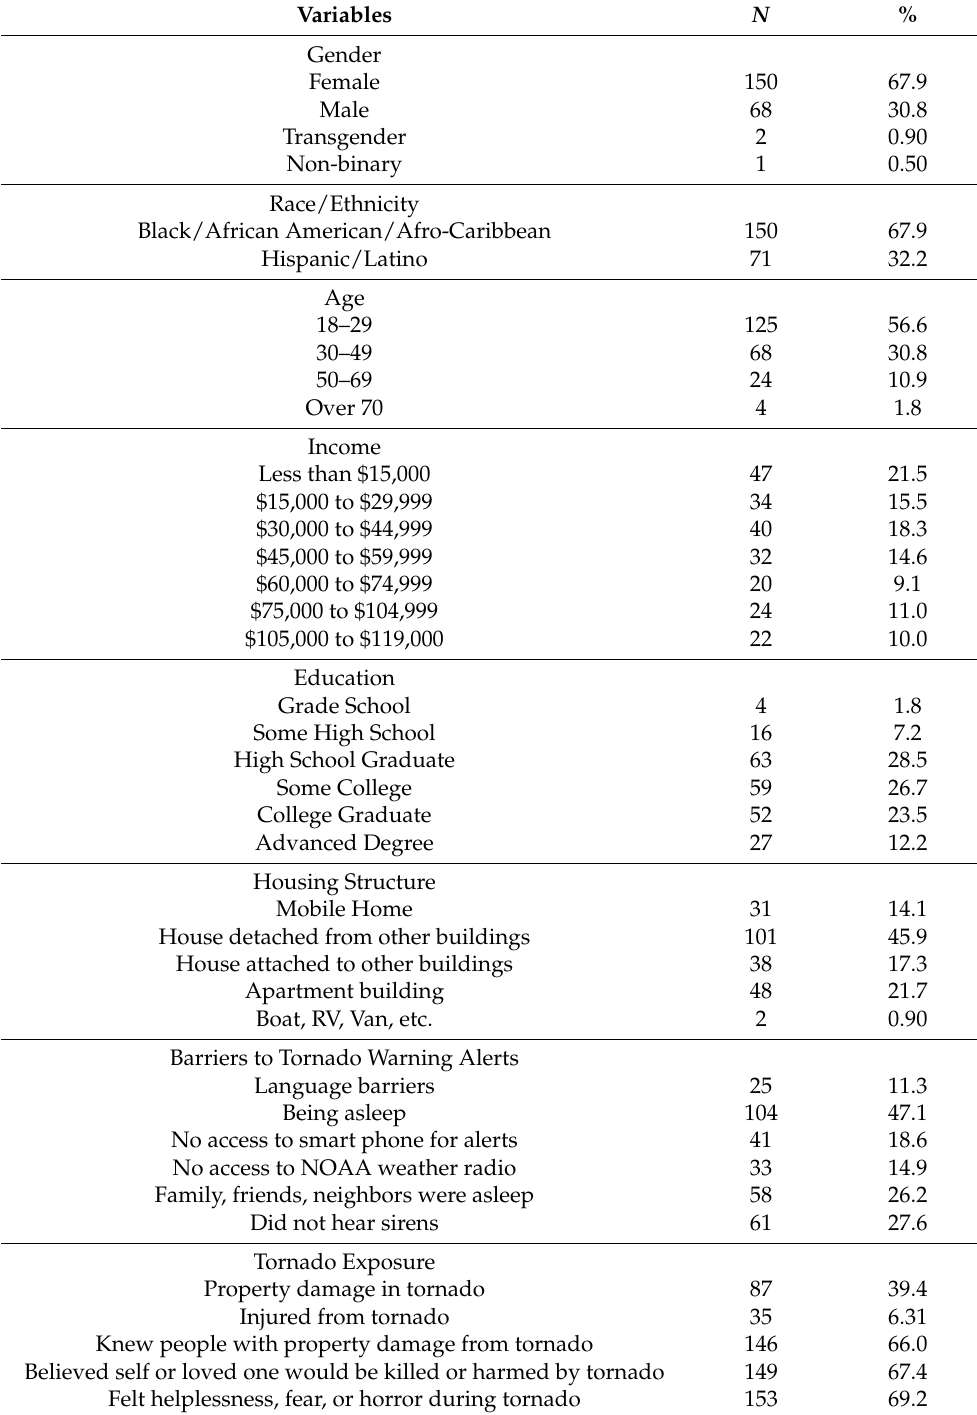
Table 1. Descriptive